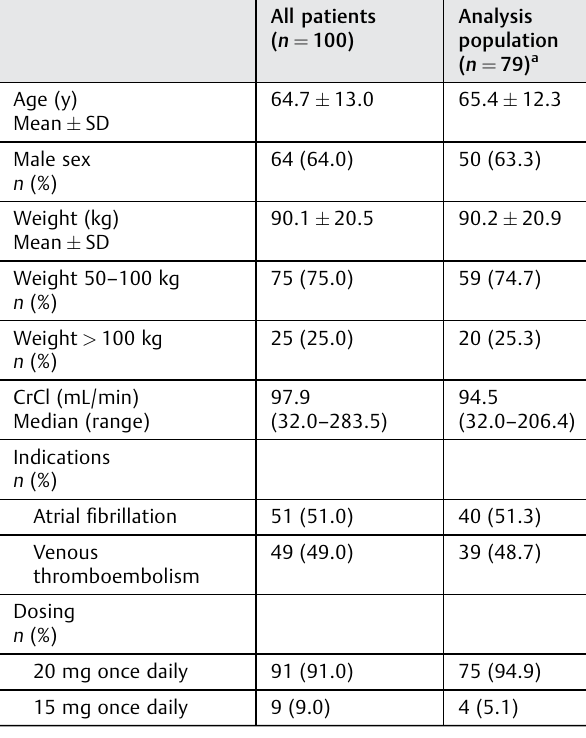
Table 1 Baseline characteristics of the entire study population and the analysis population